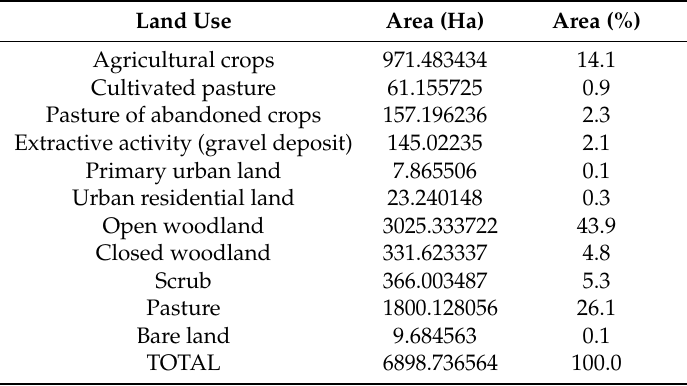
Table 1. Major land uses and area calculated with GIS.